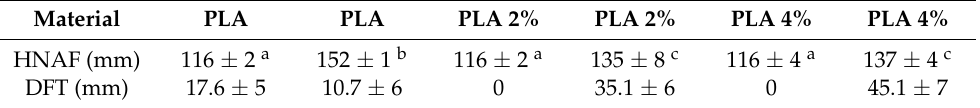
Table 2. Maximum heights obtained by node assist formability before film breakage and distance from the top formed specimen to the first tear. Different letters a, b, c represent the statistical difference (ANOVA, p < 0.05) between the properties of the materials.